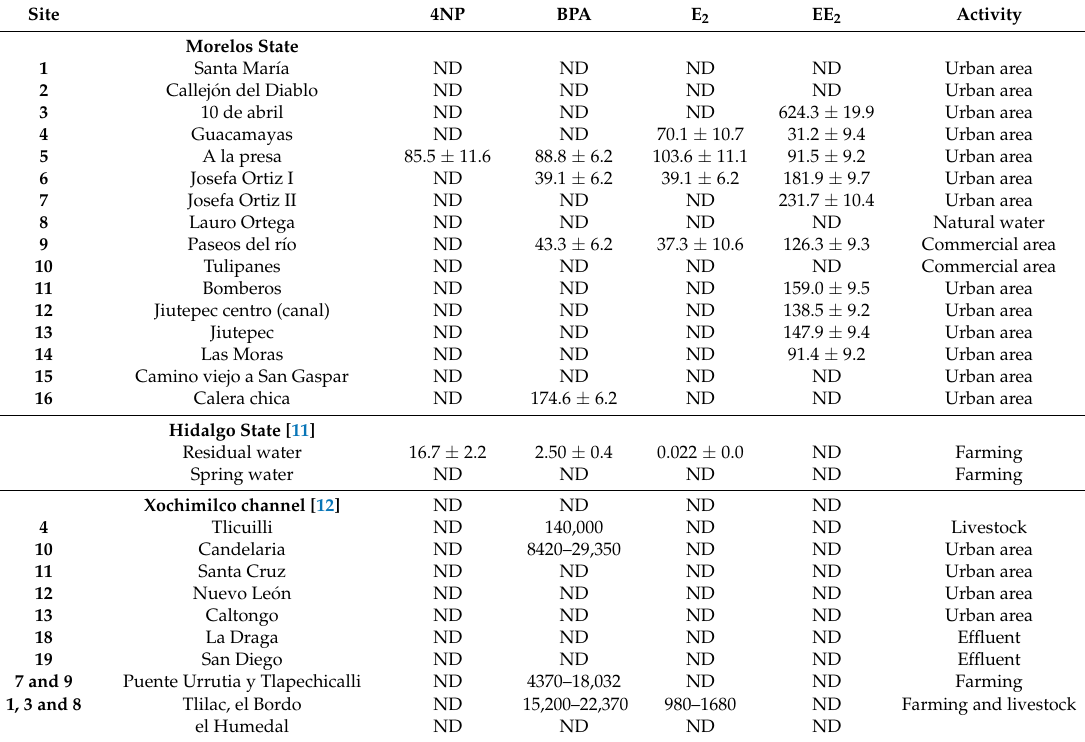
Table 3. EDC concentrations detected in surface water samples and comparisons with respect to